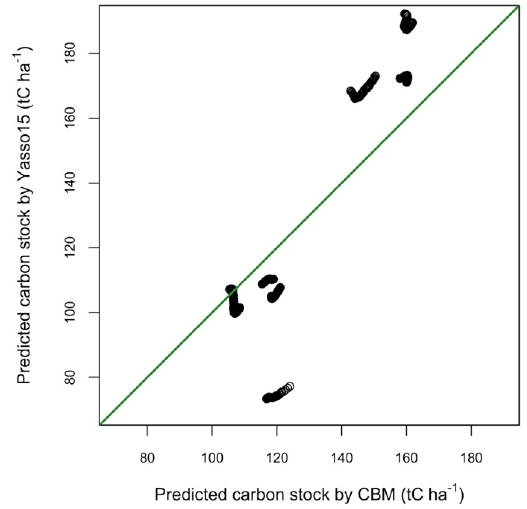
Figure 4. Reciprocal achievement of simulated values by the two models. Grouping of values on the graph is related to the stratification on forest types and climates. Green line represents 1:1 match.